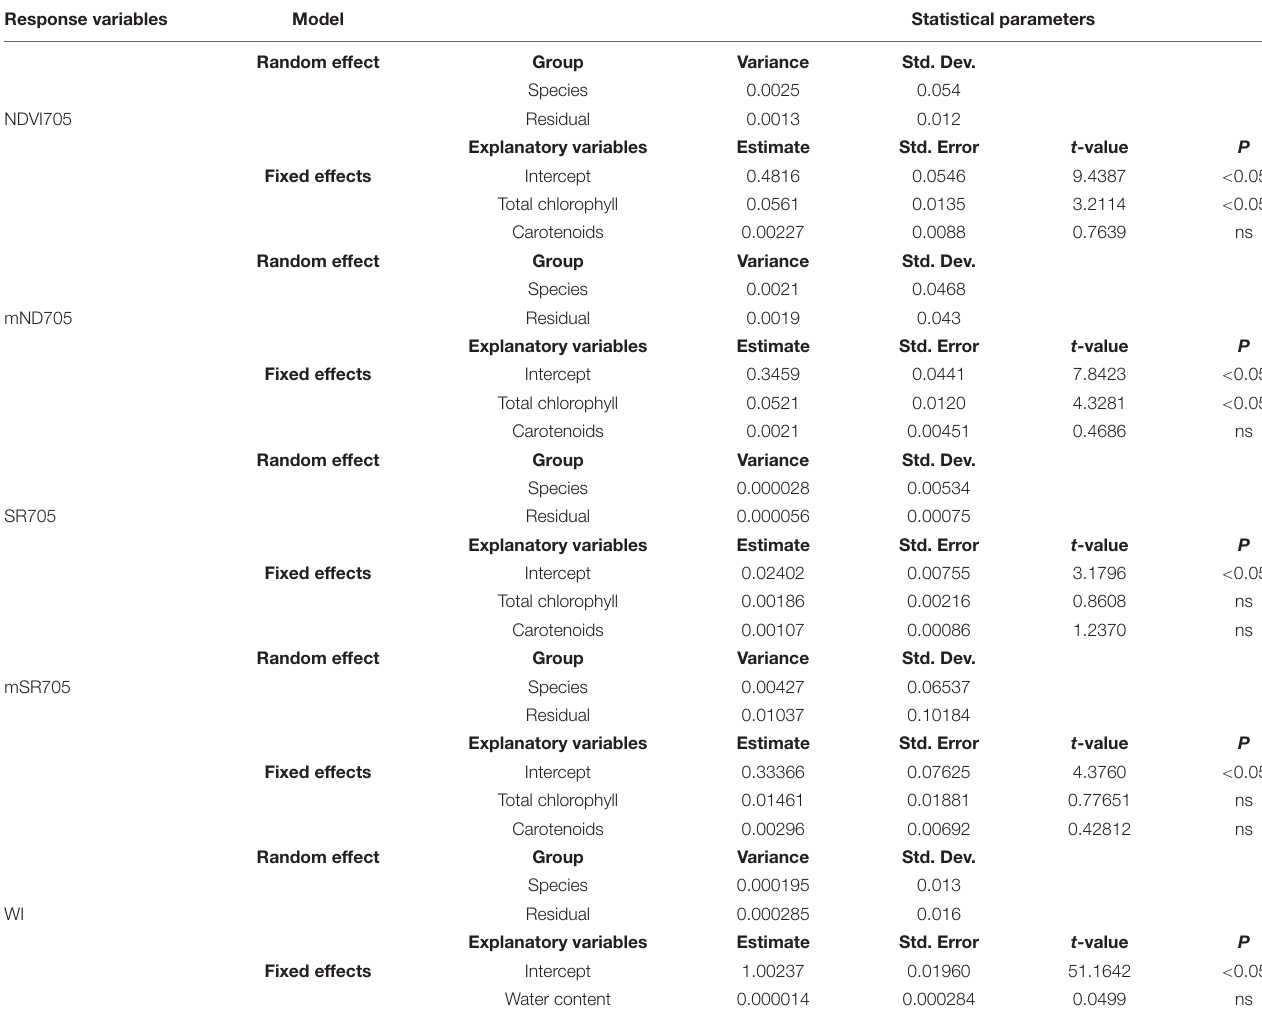
TABLE 2 | Results of the generalized mixed effect linear models (GLMMs) evaluating the effects of total chlorophyll and carotenoids on spectral reflectance indices (NDVI705, mND705, SR705, and mSR705), and the effects of water content effect on Water Index (WI). Response